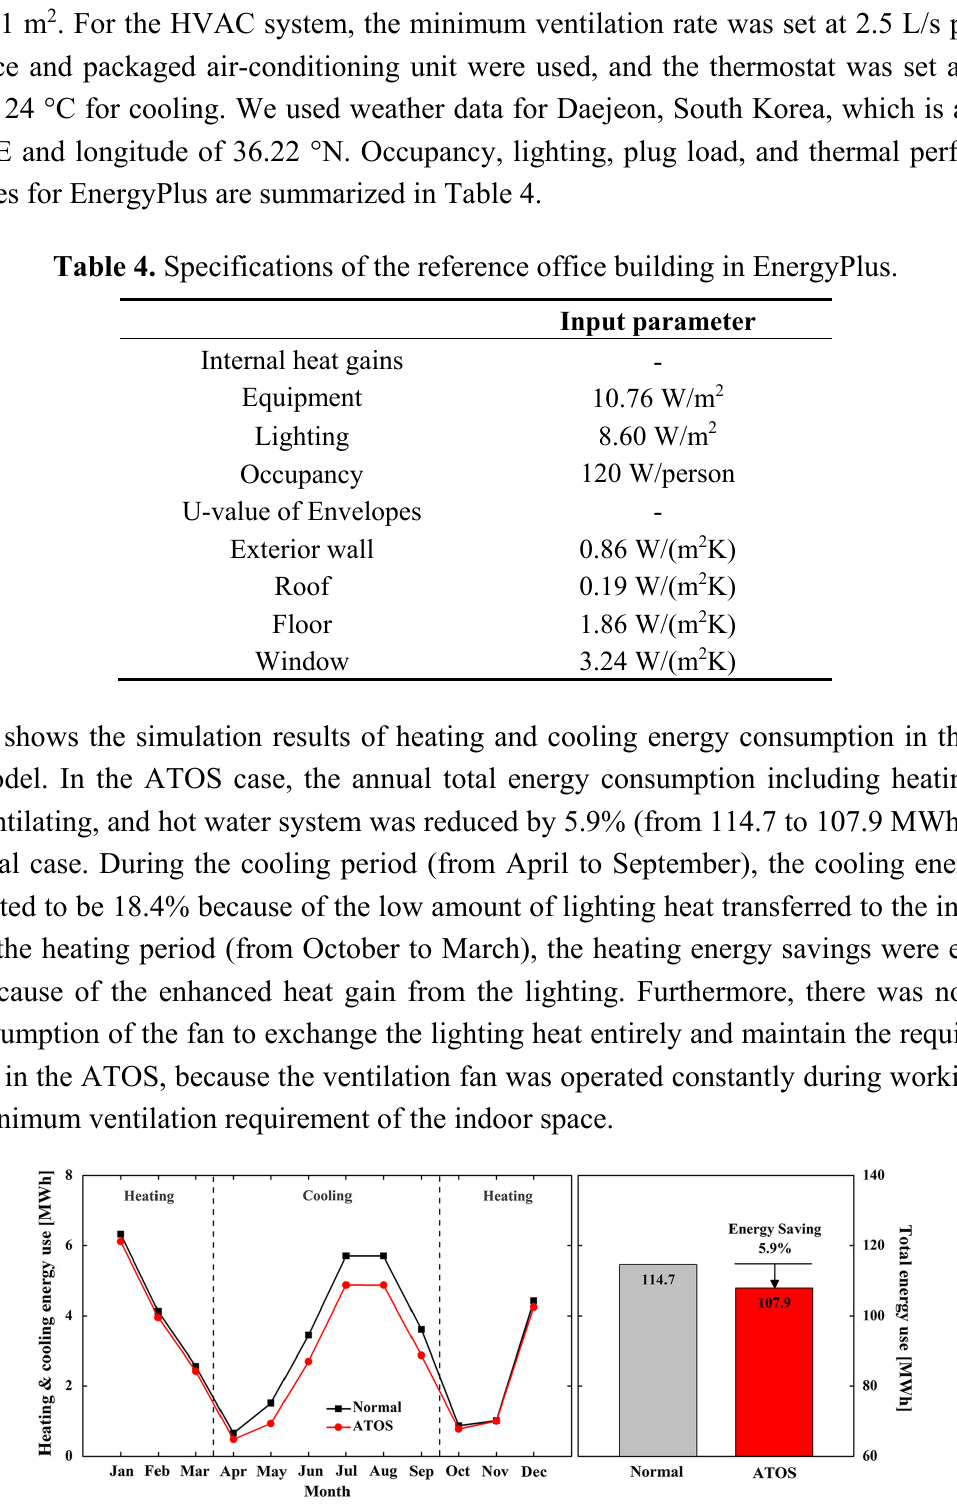
Figure 7. Monthly energy consumption for heating and cooling and the annual total energy savings of the reference commercial building model under ATOS